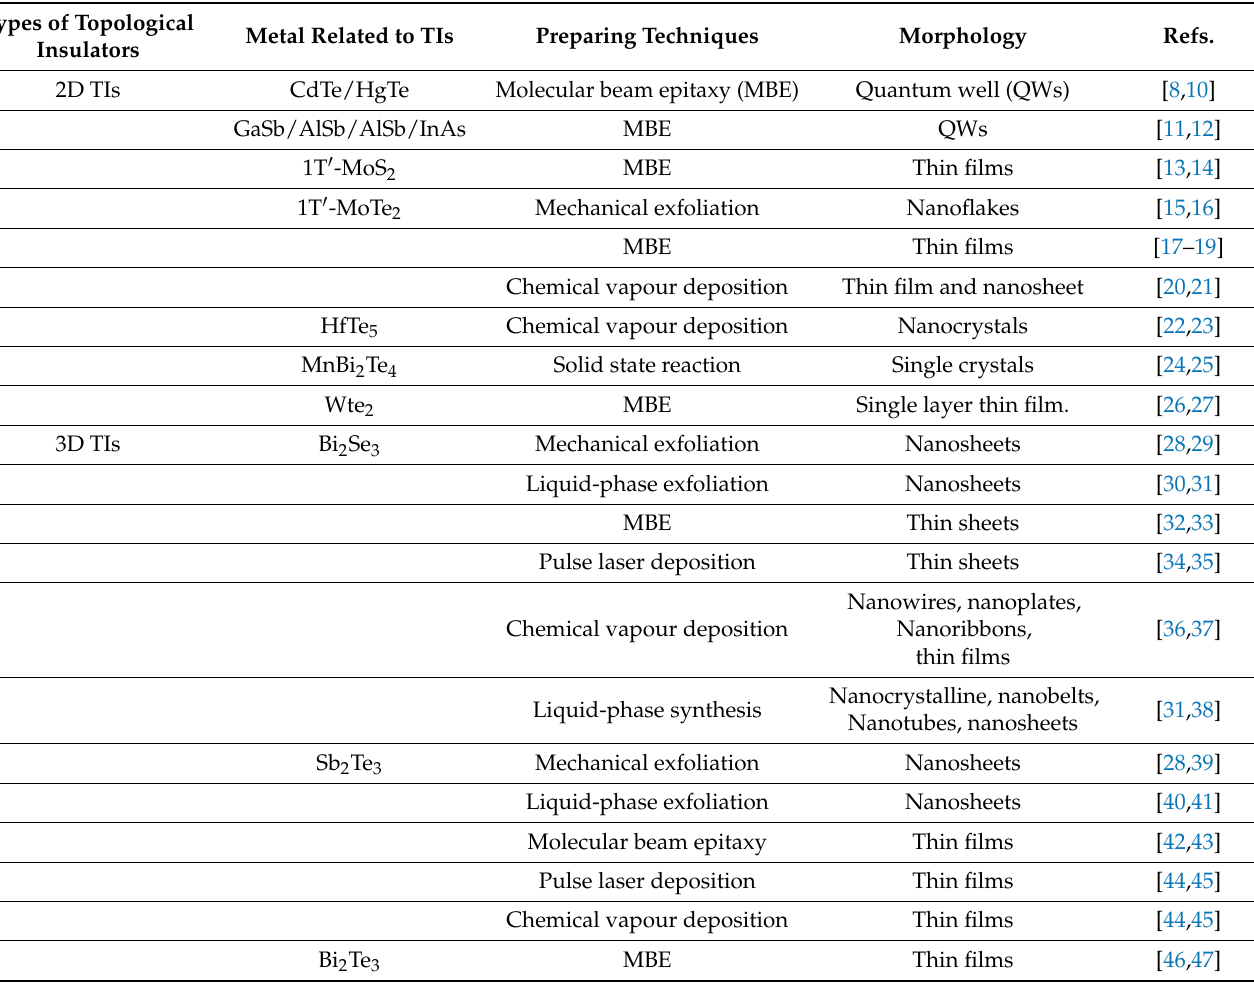
Table 1. The procedures used to prepare typical